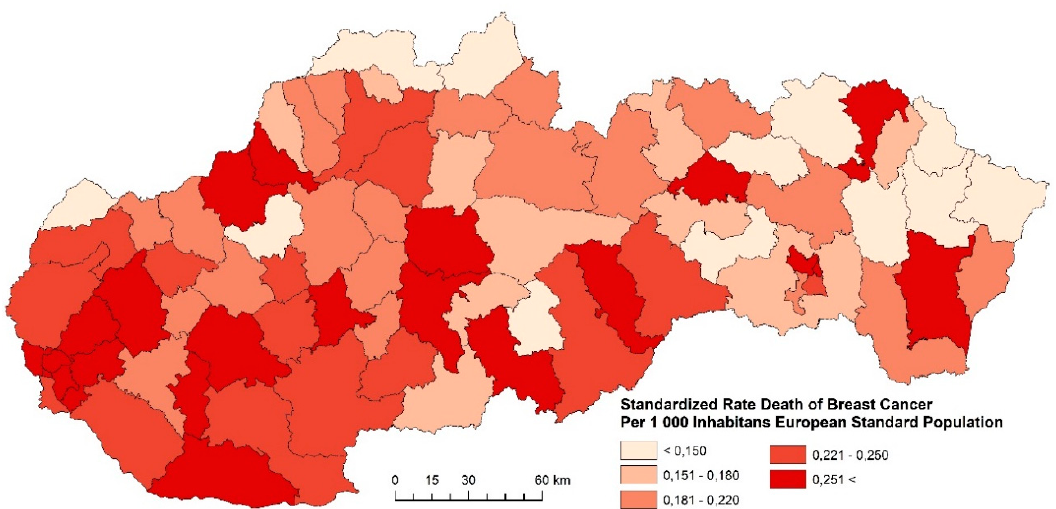
Figure 8. Standardized death rate of breast cancer per 1000 inhabitants of European Standard Population, 2001–2006. Source: Statistical Office of the Slovak Republic, 2019.